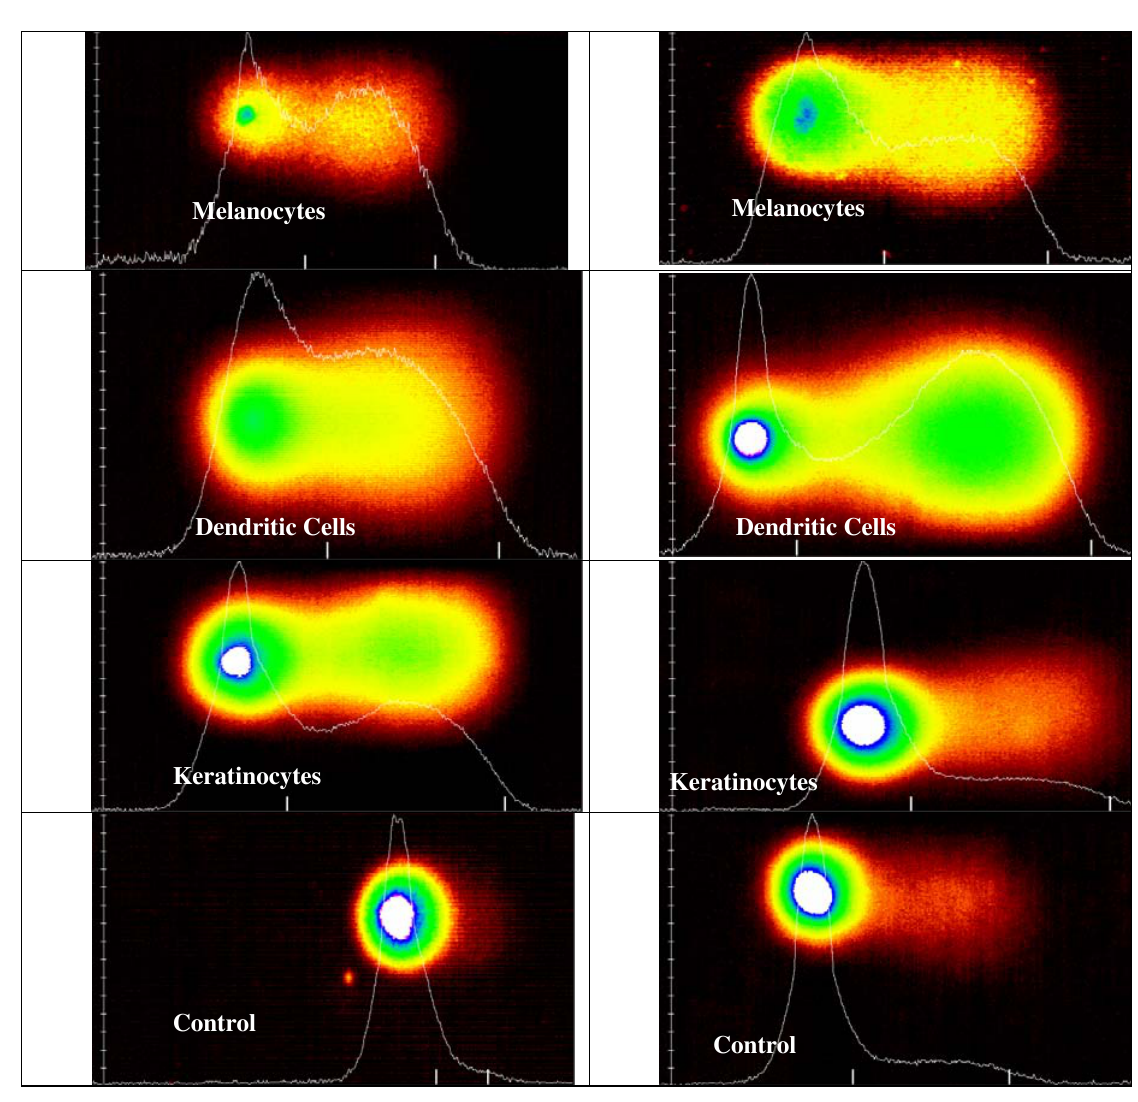
) to melanocytes, dendritic cells and 10